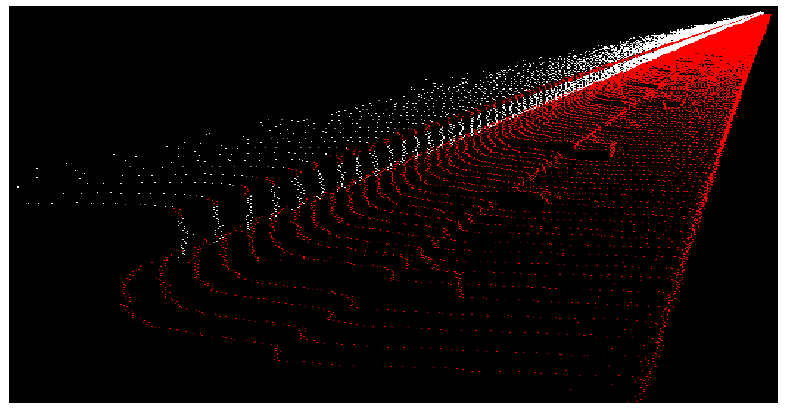
Figure 9. The points that had to be manually eliminated from the scanned point cloud are marked in red.